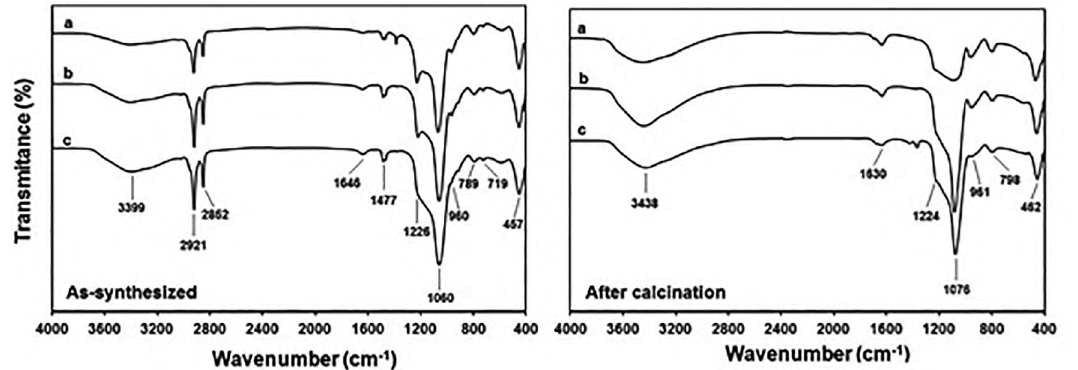
Figure 5. Infrared spectra of the samples of (a) MCM-41, (b) Al-MCM-41(50), (c)